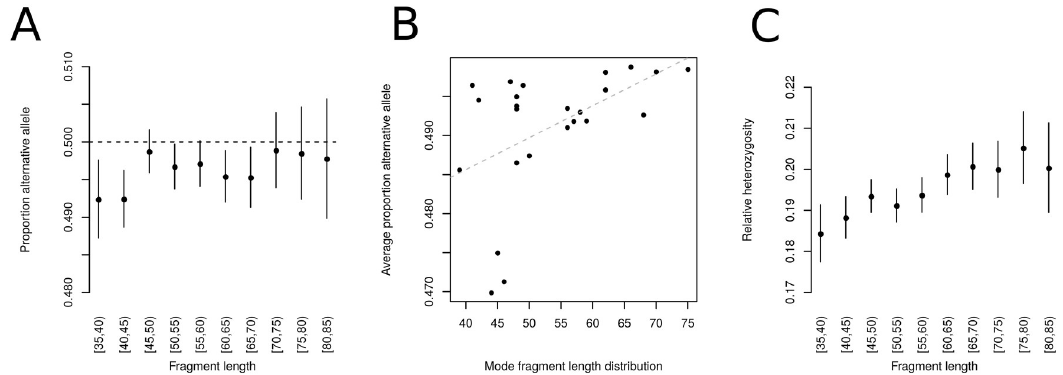
Fig 2. Connection between fragment length and reference bias. (A) Proportion of alternative allele for different fragment length bins in the high coverage individual sf12. (B) Correlation between average proportion of alternative alleles and the mode of the fragment size distribution across all investigated individuals. (C) Proportion of heterozygous sites among all sites with sufficient coverage for different fragment length bins in the high coverage individual sf12. All error bars indicate two standard